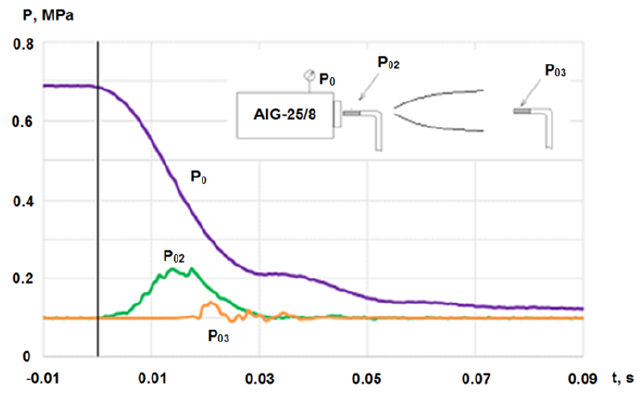
Figure 6. Typical pressure records in the experiment.